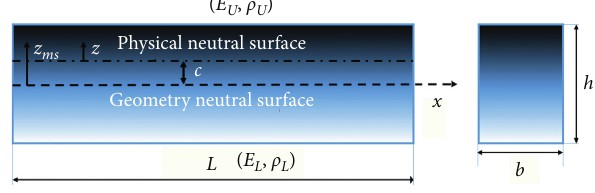
Figure 1: Modeling of a FG